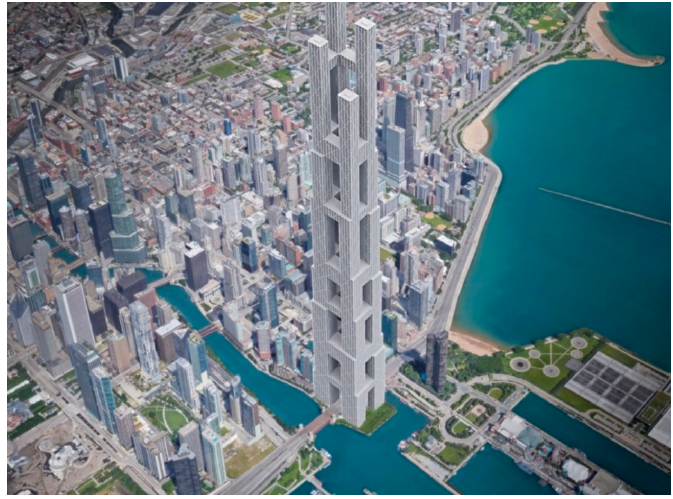
Figure 10. Mile-high superframed conjoined tower design project.